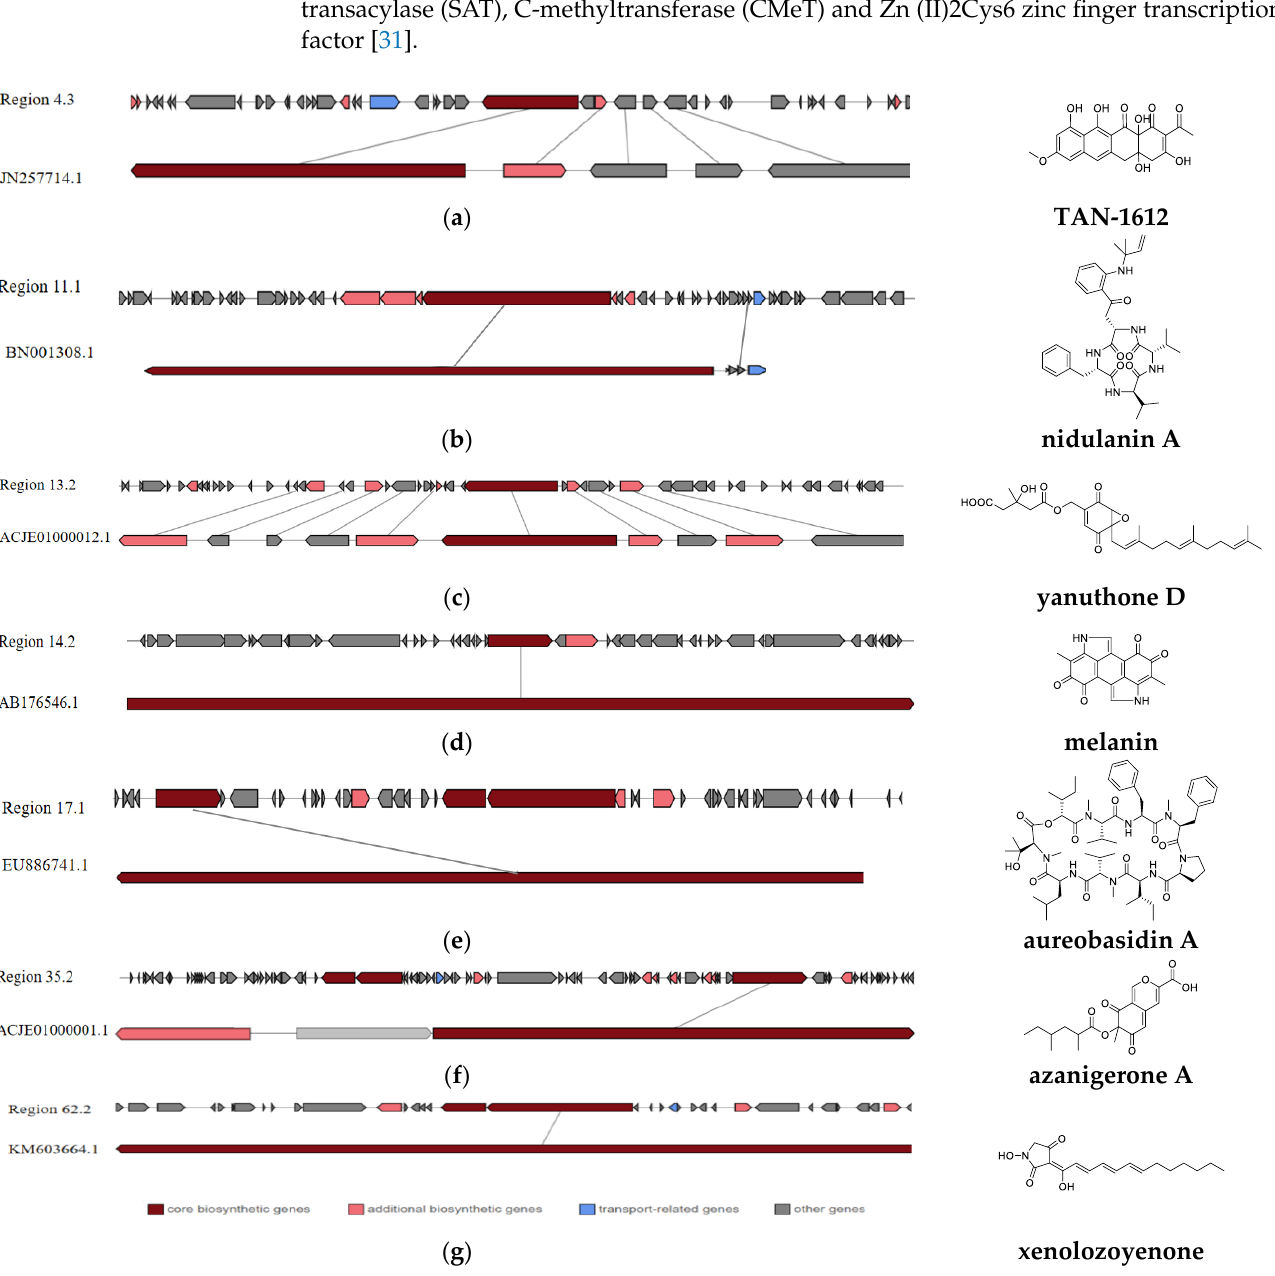
Figure 6. Seven identified BGCs with over 93% identity in strain L14 responsible for biosynthesis of TAN-1612 ( a ), nidulanin A ( b ), yanuthone D ( c ), melanin ( d ), aureobasidin A ( e ); azanigerone A ( f ) and xenolozoyenone ( g ).